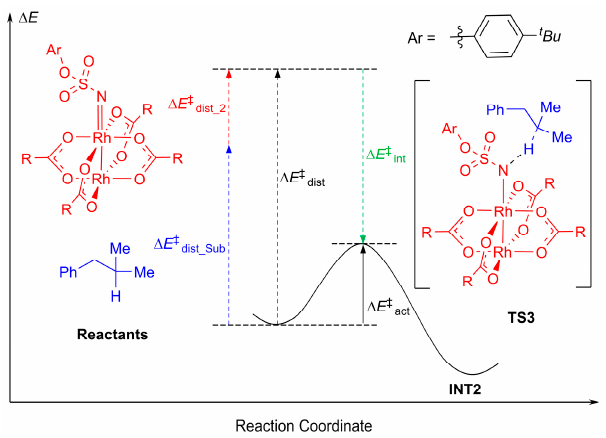
Figure 9. Distortion/interaction model.